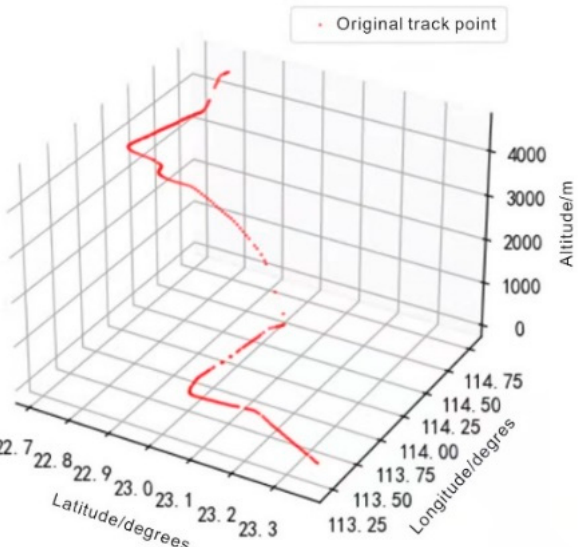
Figure 4. Original trajectory point.